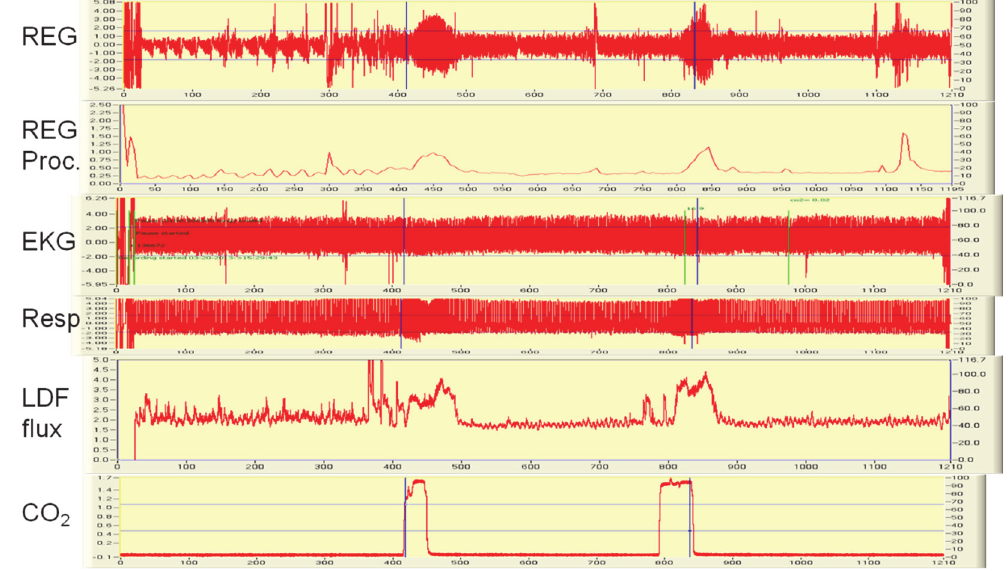
Fig. 3. Impact of CO 2 inhalation on LDF flux and REG signals, in real time: CO 2 increases were followed by simultaneous increases in LDF flux and REG signal amplitudes. For all traces, Y axis is shown in volts; X axis is shown in seconds. Traces, from top, are REG raw signal; REG proc (processed signal, displayed as a running integral); EKG; Respiration (measured by bioimpedance); LDF flux; inhaled CO 2 .